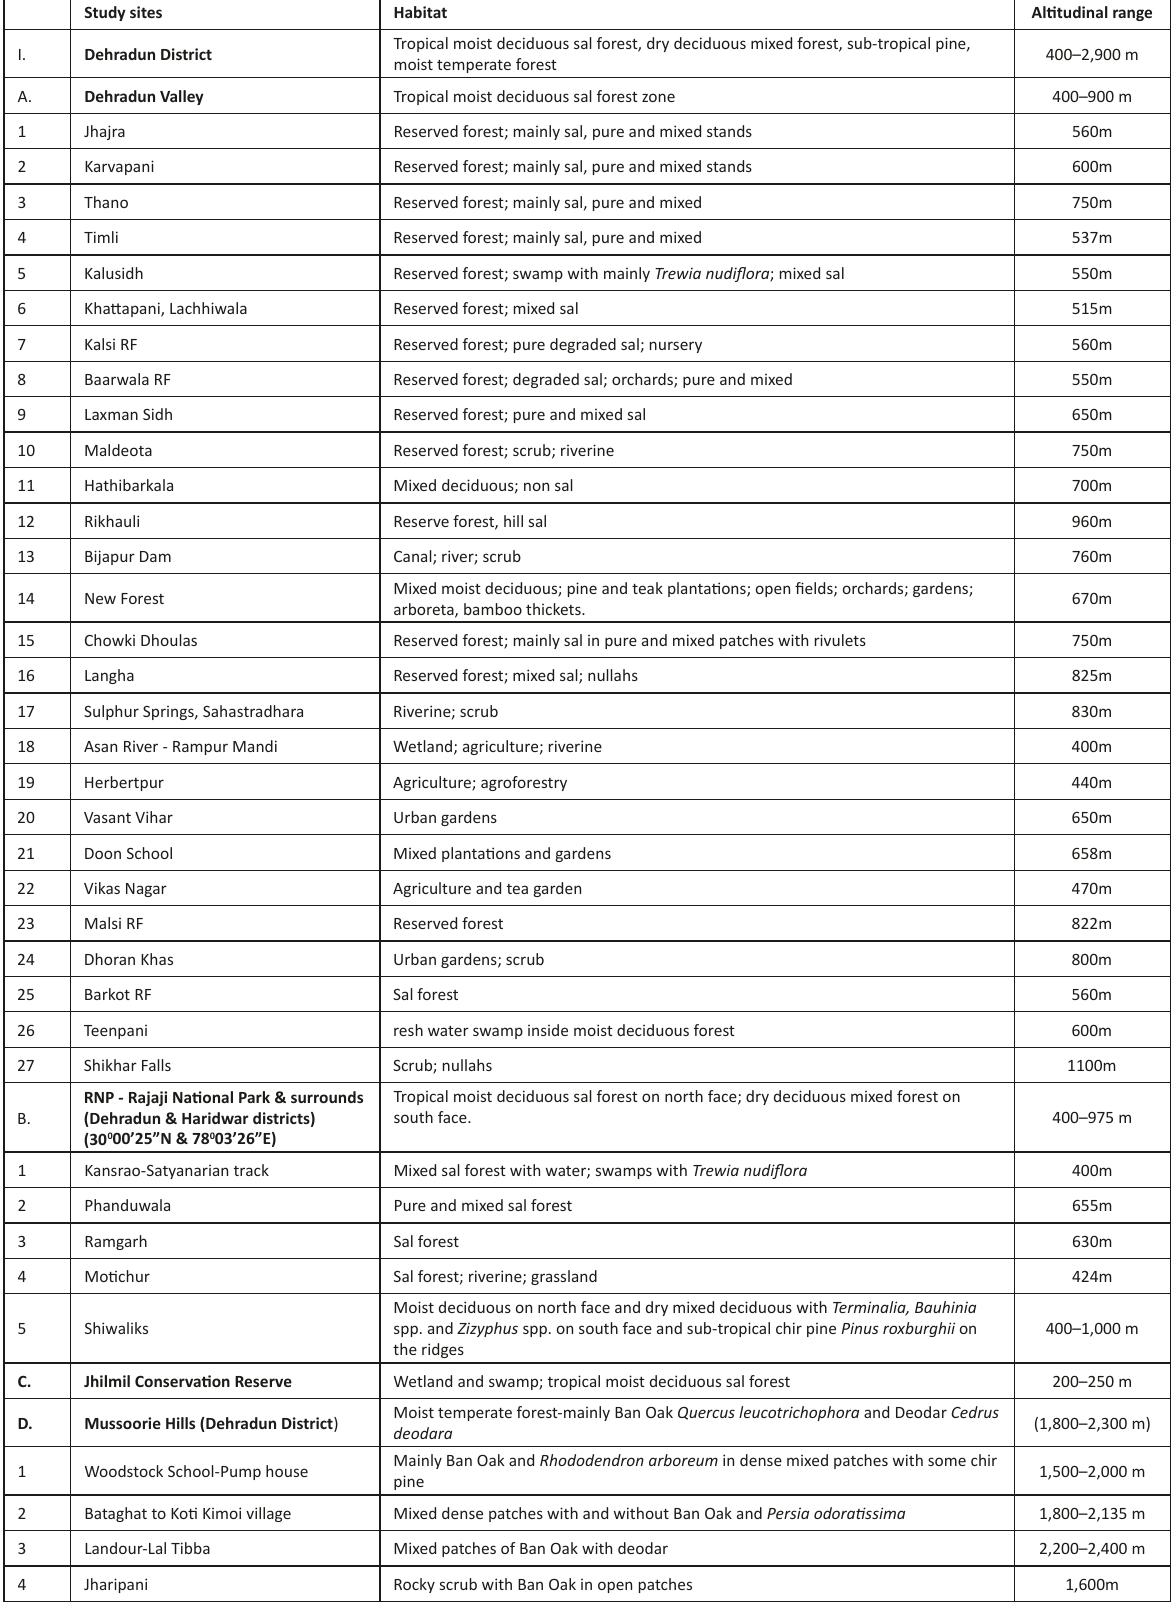
Table 1. Study sites in